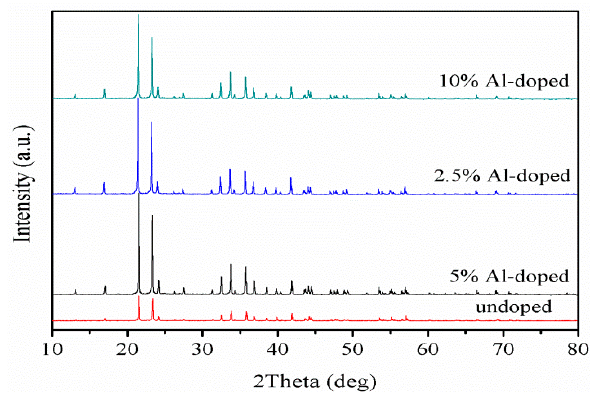
Figure 3. XRD patterns of undoped and Al-doped CLBO crystals.